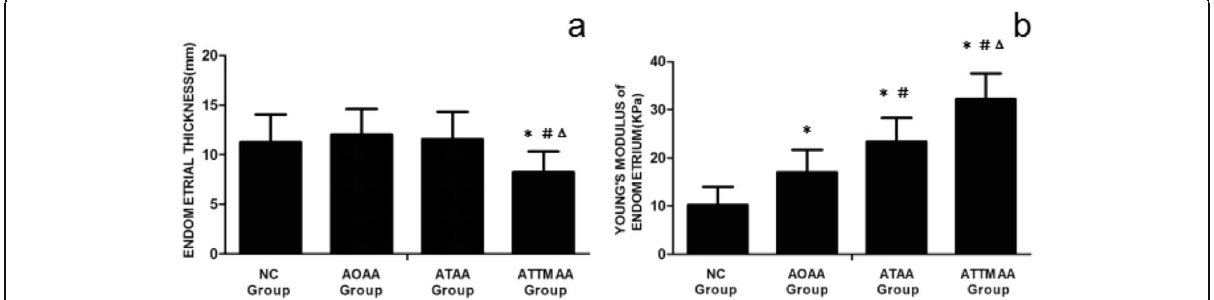
Fig. 7 Young ’ s modulus endometrium and endometrial thickness in the NC group, AOAA group, ATAA group, and ATTMAA group. a Endometrial thickness in the NC group, AOAA group, ATAA group, and ATTMAA group. b Young ’ s modulus of the endometrium in the NC group, AOAA group, ATAA group, and ATTMAA group. * p < 0.05 vs NC group. # p < 0.05 vs AOAA group. Δ p < 0.05 vs ATAA